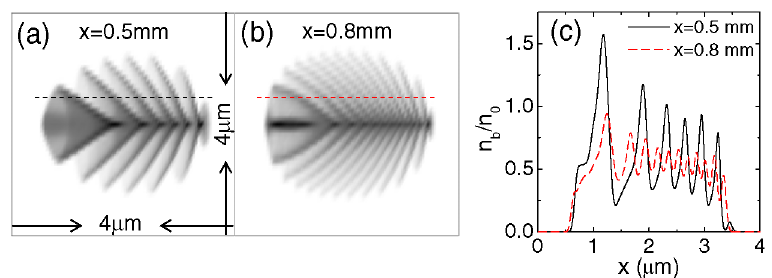
FIG. 5. Microbunching during deceleration. Snapshots of bunch density for the propagation distances (a) x ¼ 0 : 5 mm and (b) x ¼ 0 : 8 mm . (c) Display of bunch density distributions along the dashed lines in (a) and (b). Simulation parameters are the same as in Fig.